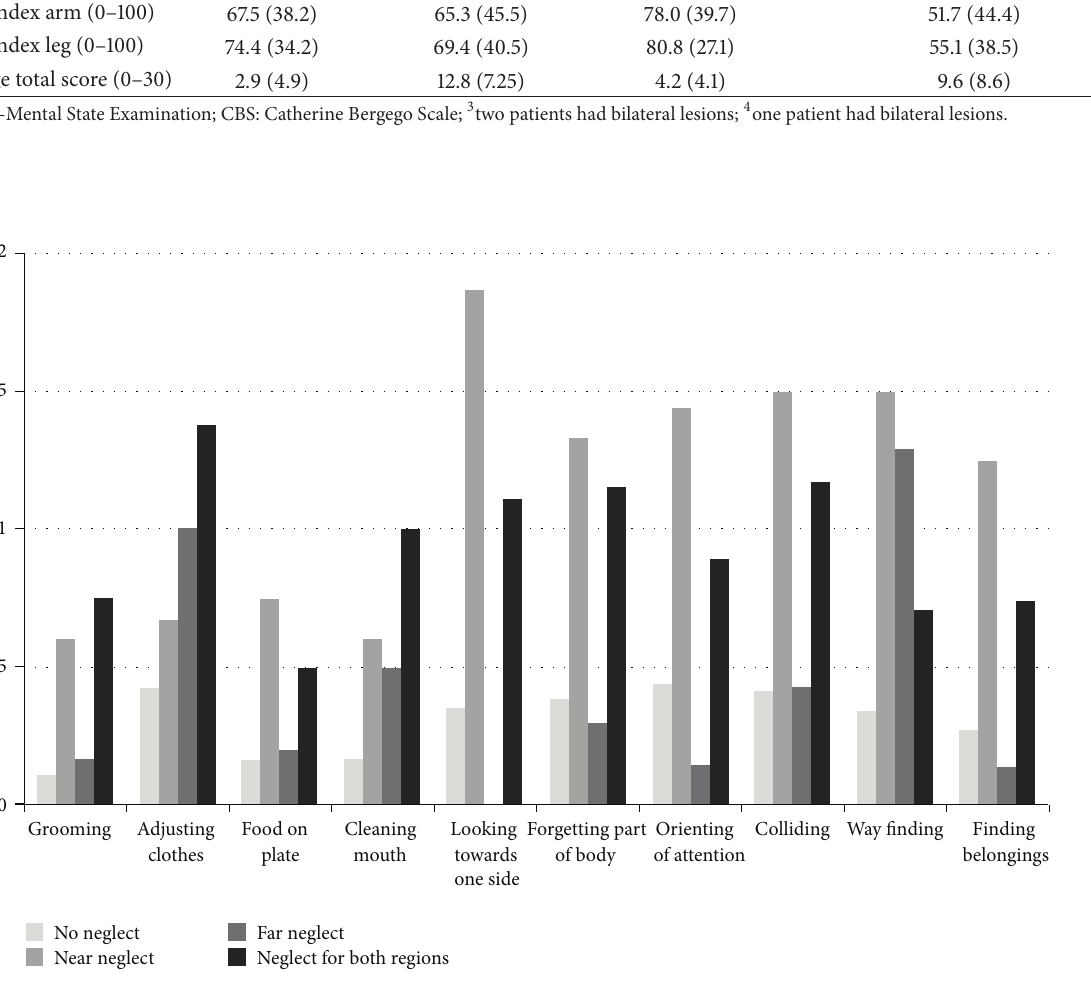
Figure 1: Average scores on all specific items of the CBS, split for groups based on the shape cancellation. Range was from 0 (no neglect) up to 3 (severe